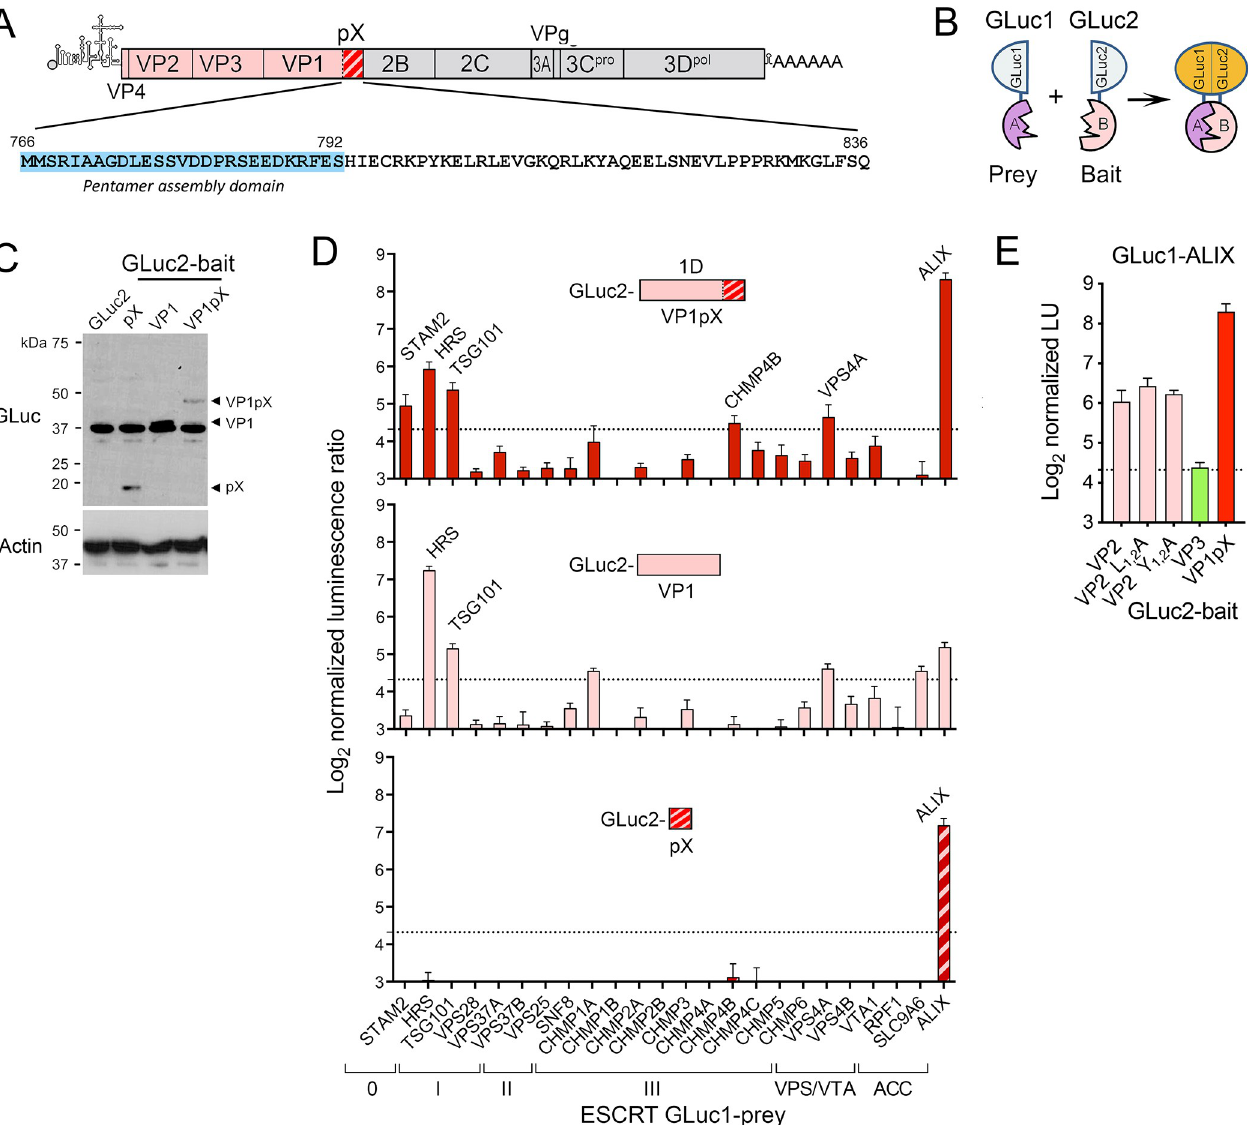
Fig 1. Protein fragment complementation screen for VP1pX interactions with ESCRT. (A) HAV genome organization: capsid proteins are in color with pX hatched. Below is the pX sequence of p16 virus. (B) Protein-fragment complementation assay with ‘bait’ and ‘prey’ proteins fused to N-terminal GLuc1 and C- terminal GLuc2 Gaussia princeps luciferase fragments [26]. (C) Representative GLuc immunoblot showing expression levels of GLuc2 bait proteins fused to VP1pX (1D), VP1, or pX in 293T cells. Actin included as a loading control. (D) Screen for interactions of ( top ) VP1pX, ( middle ) VP1, and ( bottom ) pX with ESCRT components. Normalized light units (LU) > 20 (dashed line) exceed values from a large panel of control prey proteins [27]. Acc: ESCRT accessory protein. (E) Results of protein-fragment complementation assay assessing interactions of GLuc1-ALIX prey with VP2, VP2 late domain mutants with Ala substitutions of Leu (L 1-2 A) and Tyr residues (Y 1-2 A) ( 14 ), VP3, or VP1pX fused to GLuc2 as bait. Data in C and E are means from 2 independent experiments, each with 3 technical replicates.